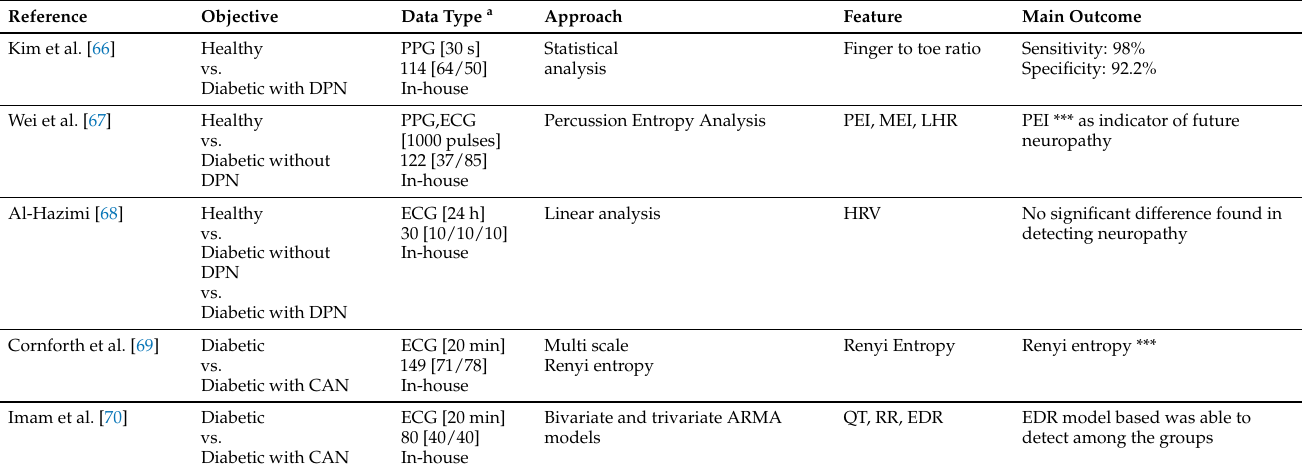
Table 4. Traditional methods for diabetes